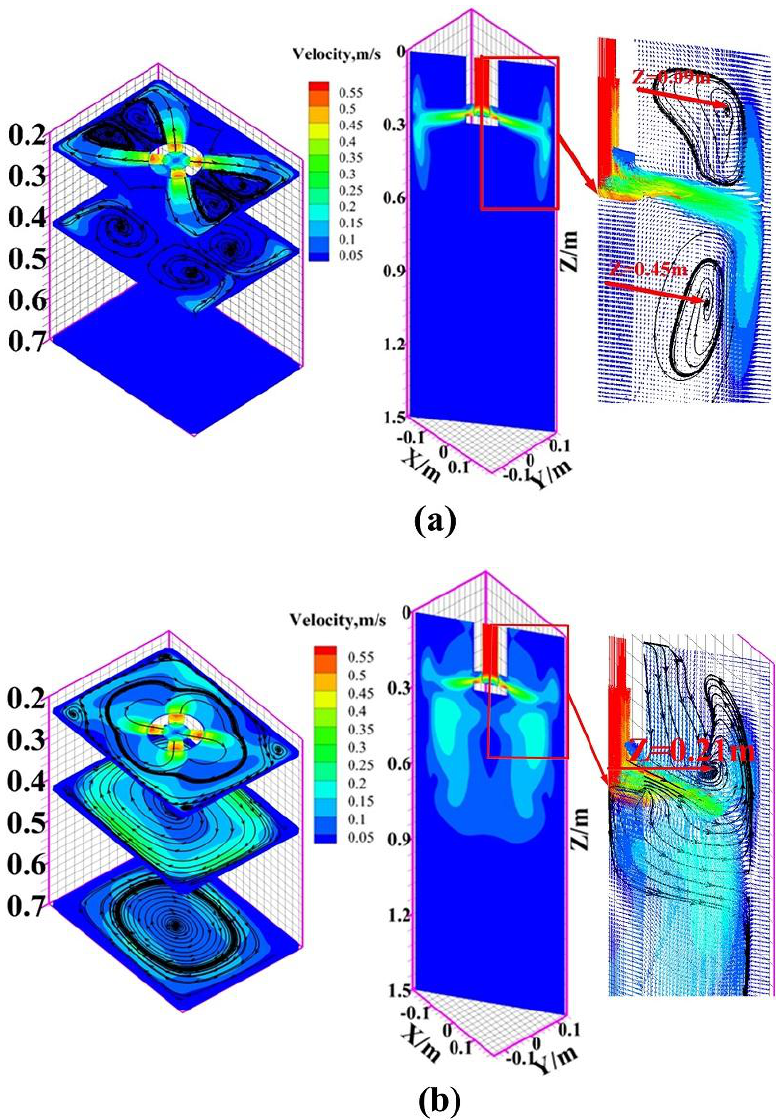
Figure 7. Velocity contour and vector in the upper part of the mold for the cases without ( a ) and with ( b ) electromagnetic stirring (EMS).